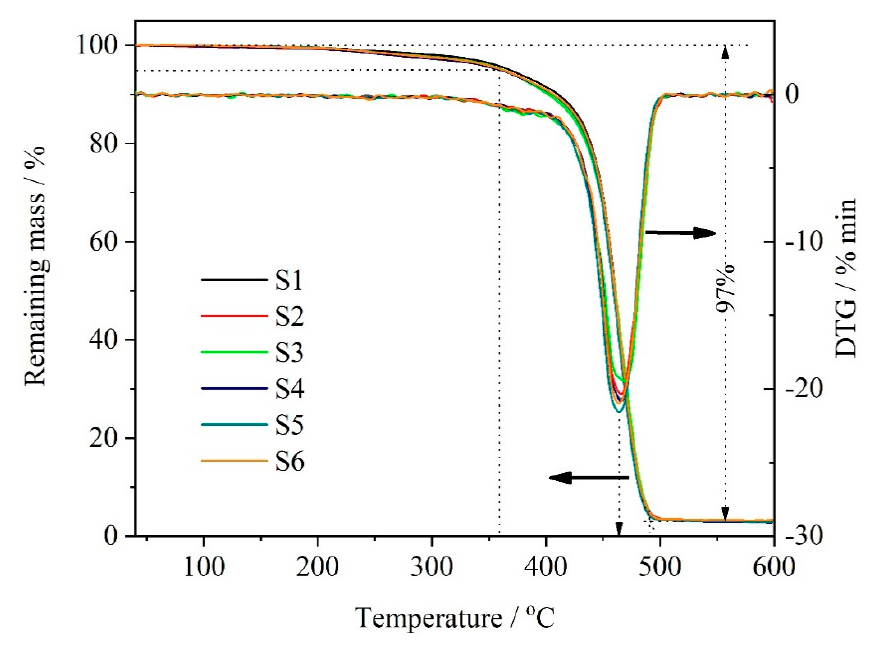
Figure 8. TG and DTG curves for elastomers.